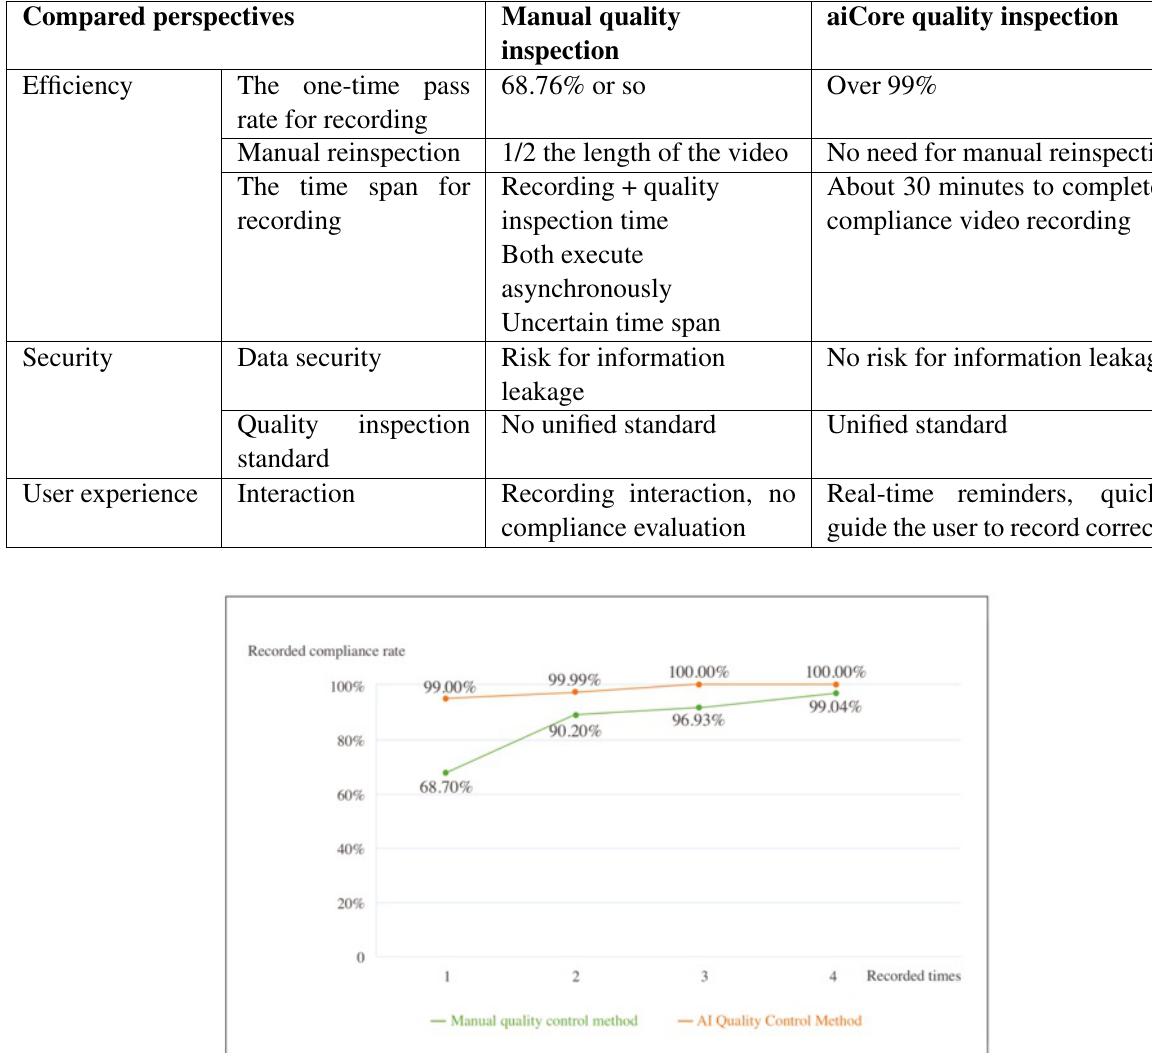
Fig. 9 The graph for recording times and recording compliance of manual and aiCore quality